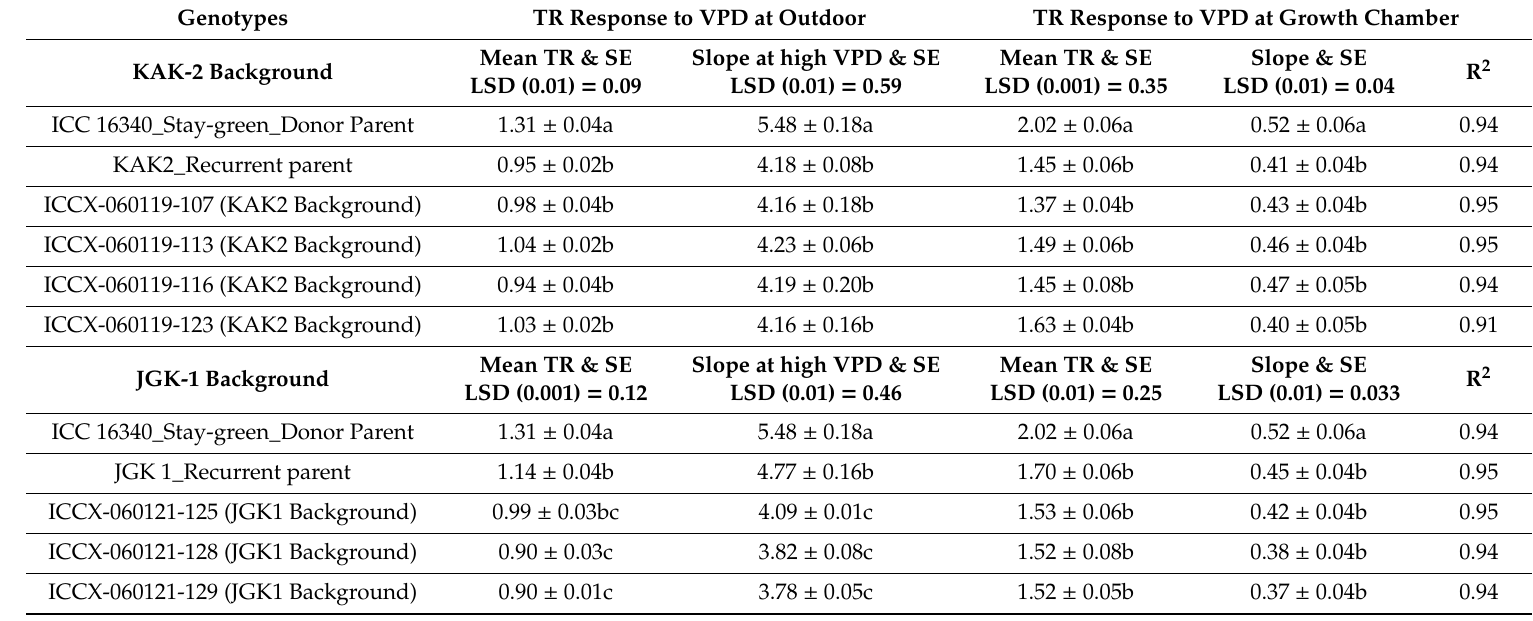
Table 3. Regression analysis of transpiration response to VPD in outdoor and growth chamber of green cotyledon trait donor genotype ICC 16340, recurrent yellow cotyledon elite cultivars KAK-2 and JGK1 and backcross introgression lines of the green cotyledon trait in these elite cultivar